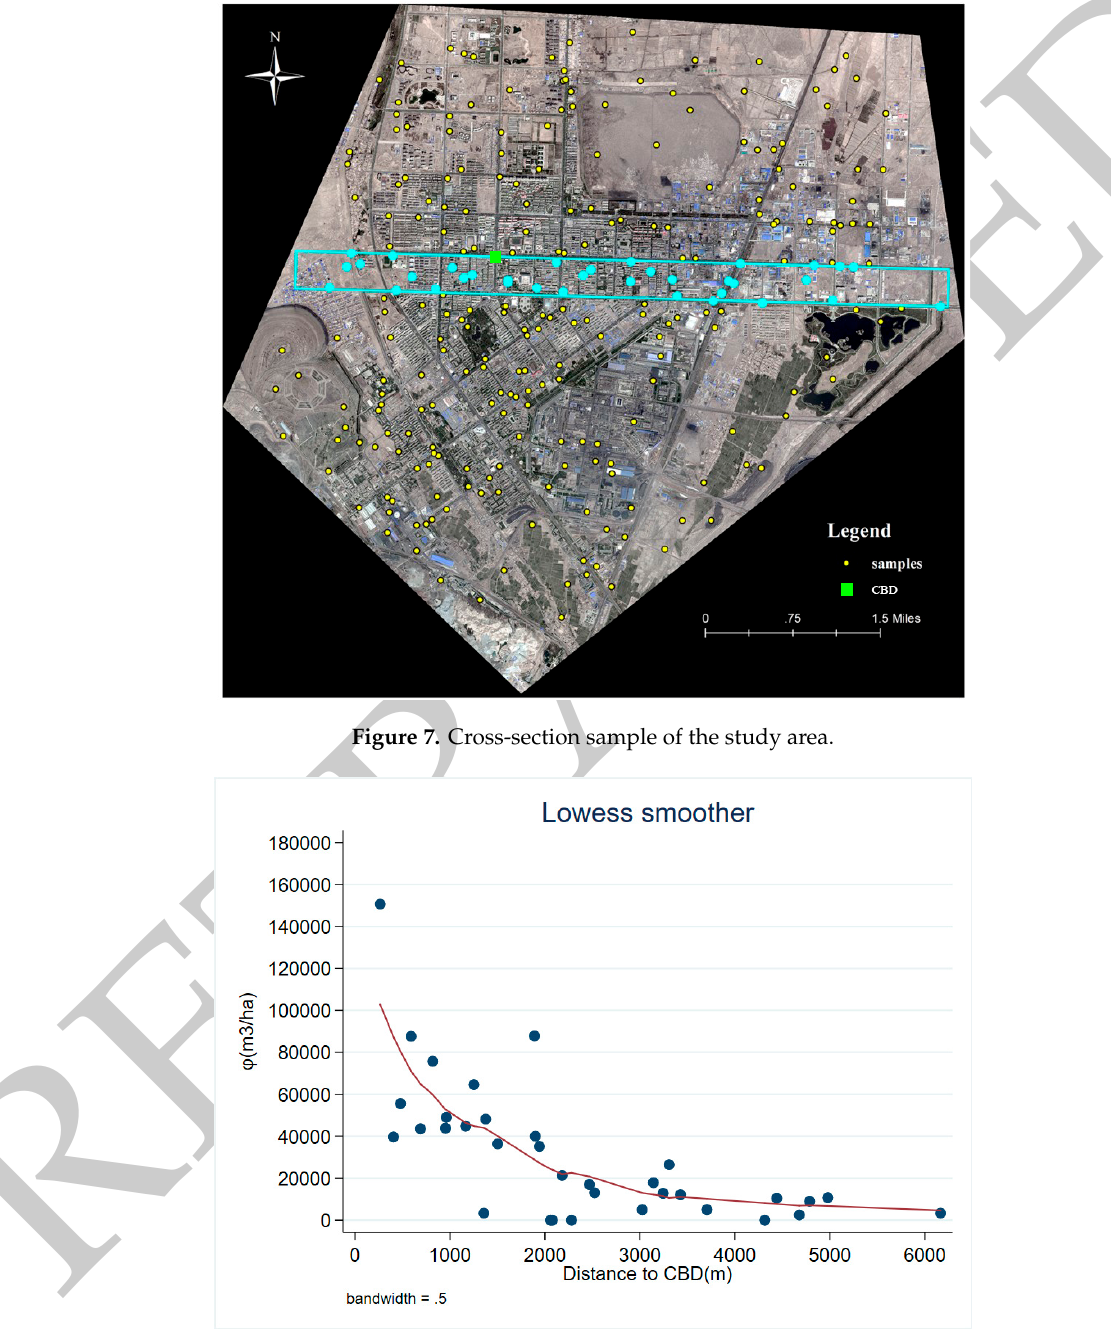
Figure 8. Relationship between cumulative metabolic rate and distance from the CBD found in cross- sectional sample. The dark dot represents the material accumulation of the sample point, and the red line is the fitting line.